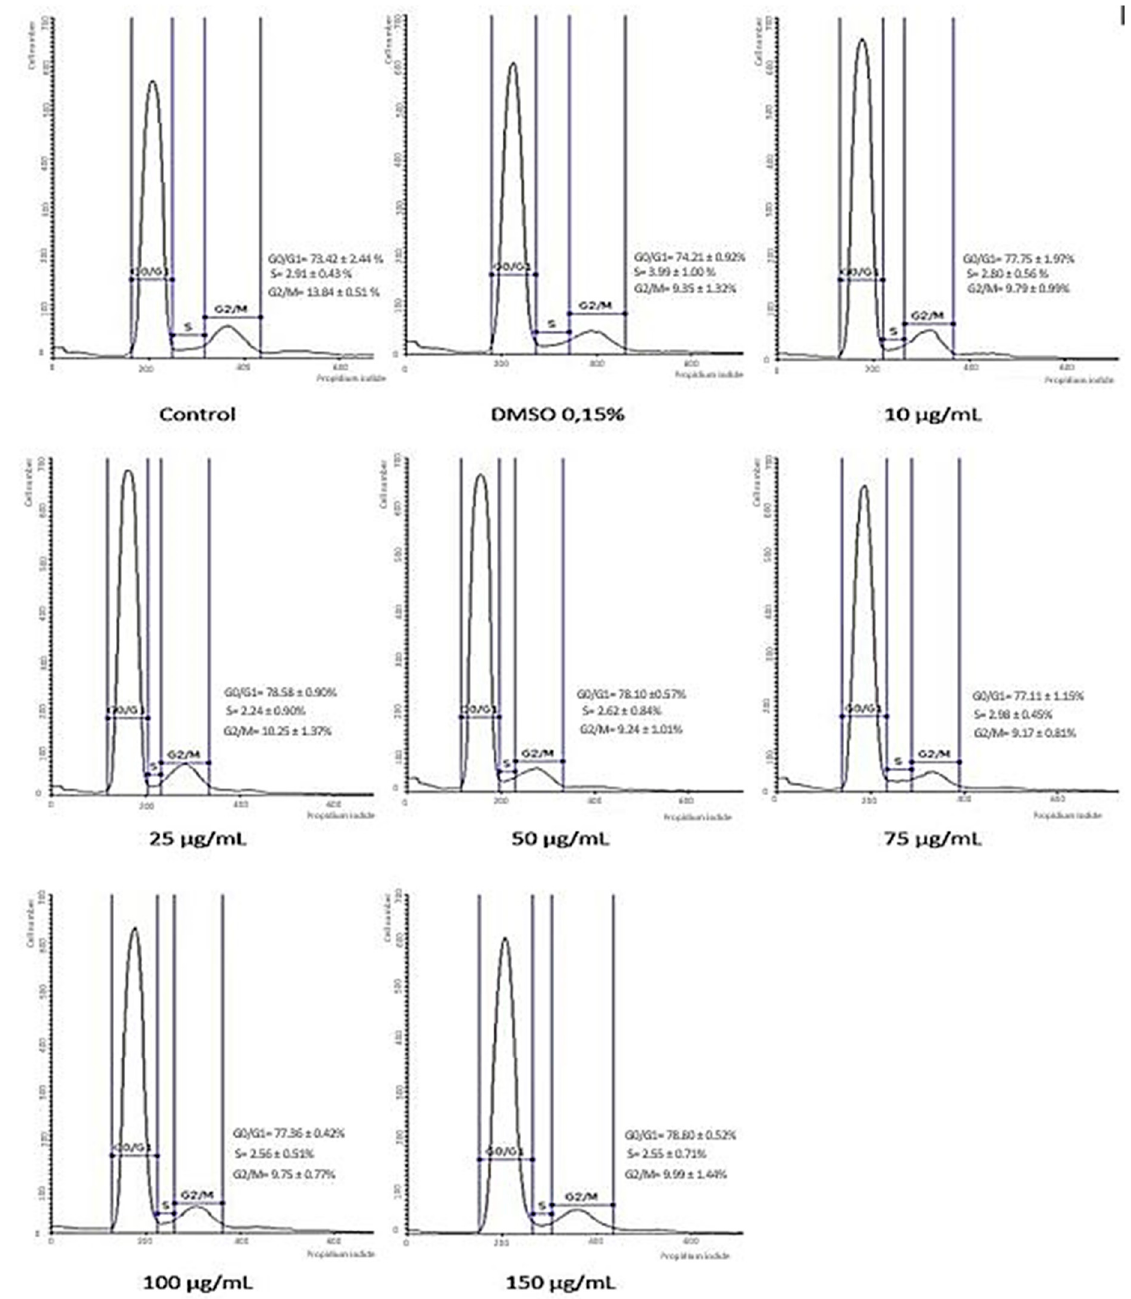
Figure 6. Cell cycle histograms determined by flow cytometry. Effects of Pg extract (10, 25, 50, 75, 100, and 150 µg/mL) on cell cycle phases (G0/G1, S, and G2/M) after 72 h exposure to Pg extract for A549 human lung adenocarcinoma cell line. Results are expressed as cell viability percentage (%) related to the control cells.